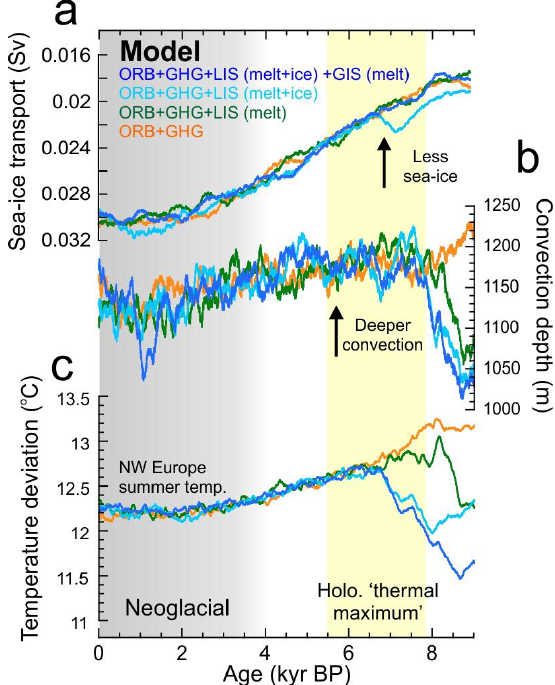
3 Fig. 6. Model outputs (499yr smoothed) from Holocene simula- tions using LOVECLIM1.2. Simulations are as described in the Supplement and with a similar set-up as Renssen et al. (2009); ab- breviations for the parameters included in each simulation are as follows: ORB, orbital insolation changes; GHG, Holocene changes in greenhouse gas concentrations; LIS (melt), modelled effects of the Laurentide ice-sheet meltwater; LIS (melt+ice) simulation in- cludes LIS meltwater, topographic and albedo effects; GIS (melt), effects of Greenland ice-sheet meltwater. (a) Modelled southward transport of sea ice through Fram Strait. (b) Changes in the maxi- mum winter convection depth in the Nordic seas. (c) Modelled July temperatures over Northwest Europe (Renssen et al.,